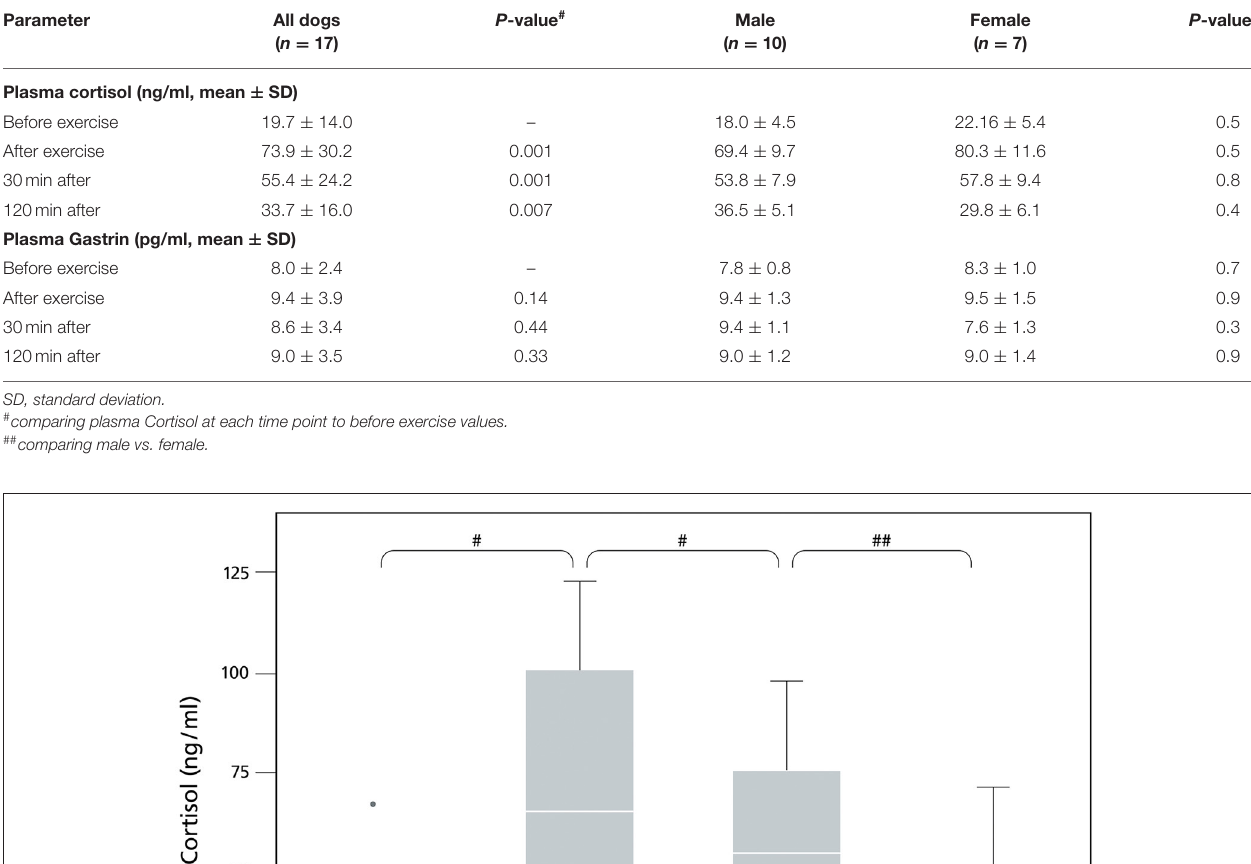
after: 116.8 ± 63.1 U/L). Lactate increased significantly ( p